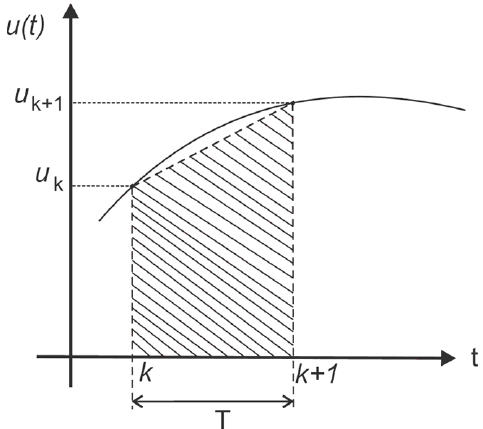
Figure 6. Approximation using trapezoidal method.